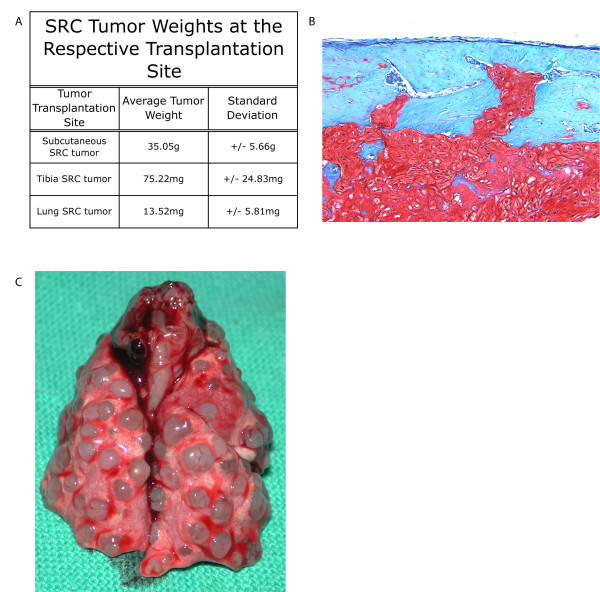
Phenotype of the Swarm Rat chondrosarcoma varies based on tumor transplantation site. (A)Tumor weight following transplantation into different sites. The average tumor weight and standard deviation are shown. The weight of the subcutaneous SRC tumor was calculated from 6 animals. The tibia SRC tumor weight was calculated based on tibia tumors isolated from 14 separate animals. The lung tumor weight represents the average weight of individual tumor nodules collected from 7 animals. The lung tumors were isolated from animals that had SRC tumor transplanted into the tibia (7 of 14 animals had lung tumors). (B)Transplantation of the SRC tumor into the tibia of Sprague-Dawley rats. Histologic micrograph at day 34 revealed increased tumor volume and invasion of the tumor into the bony cortex. Cells stained with safranin O and fast green. (C)SRC tumors detected in the lung of a rat that had the SRC tumor transplanted into the tibia. Note the presence of multiple SRC tumors. Lung tumors were detected in 50% of the animals that had the SRC tumor transplanted into the tibia. The number of lung SRC tumors in a single animal ranged from 1 to 54 (average = 10). The average size of the tumors was 2 mm. No lung tumors were detected in the animals with subcutaneous tumor transplants.